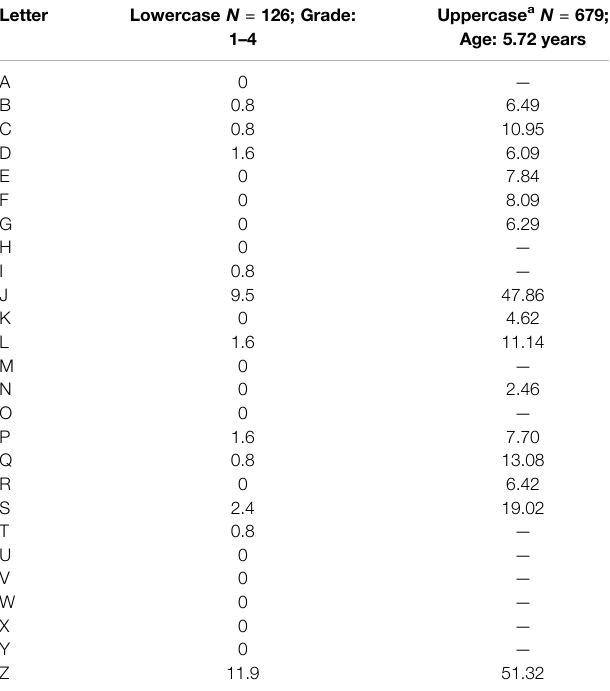
TABLE 1 | Reversal of the asymmetrical letters, in percentages, after Richmond (2012) for lowercase letters and Fischer and Luxembourger (2018a, Table 2 ) for capital